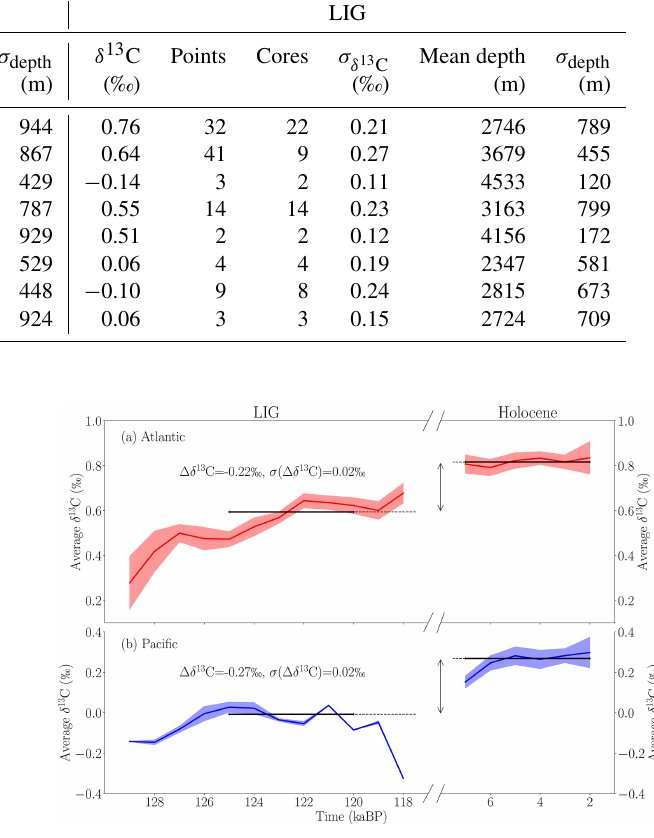
Figure 6. Comparison of volume-weighted δ 13 C for the Atlantic (red) and Pacific (blue) for the LIG and Holocene, calculated us- ing the regions from Peterson et al. (2014) from data covering all depths. Solid coloured lines indicate the mean volume-weighted δ 13 C, and the shading indicates the volume-weighted sum of square deviations from the mean. The horizontal bars indicate the mean of the stable period determined from the regional analysis as defined in Sect. 3.1 (LIG: 125–120kaBP; Holocene: 7–2kaBP), with the (cid:49)δ 13 C indicating the mean anomaly between these two averages and the standard deviation ( σ ( δ 13 C),